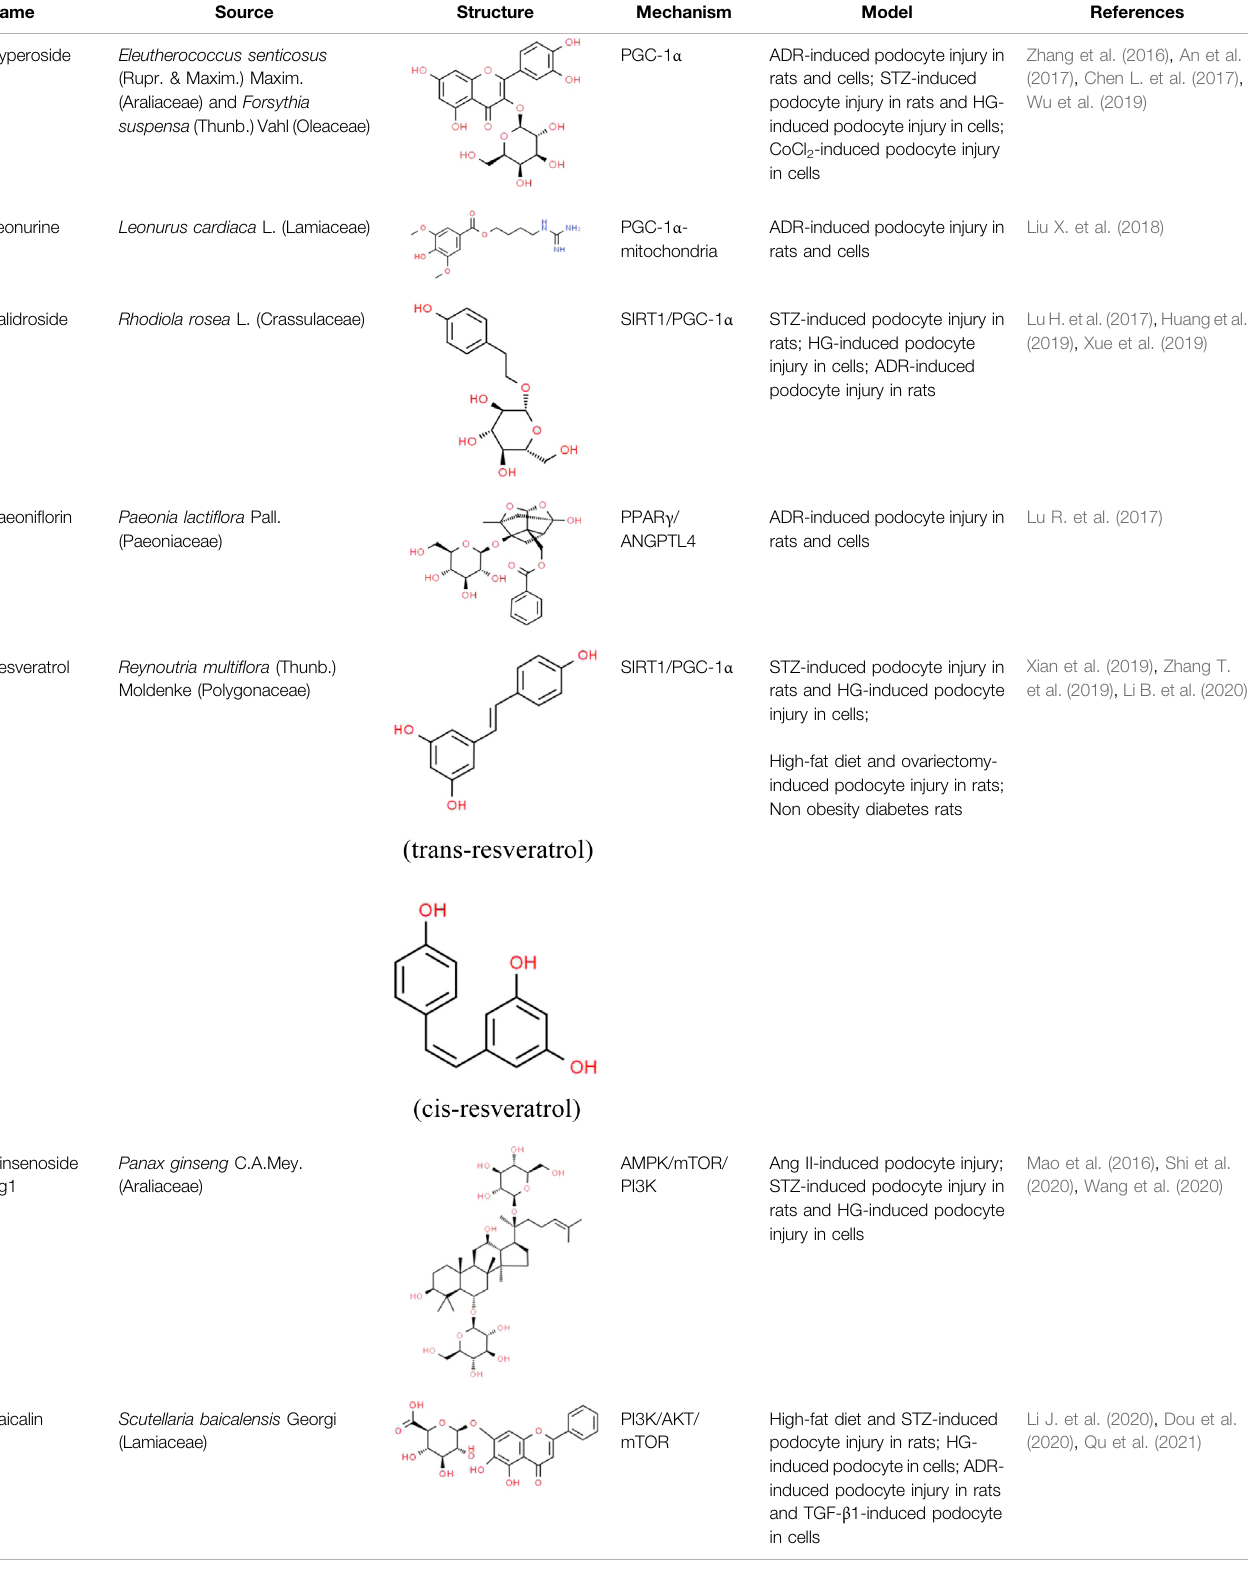
TABLE 1 | ( Continued ) Active ingredients of TCM potential therapeutic effects on podocyte